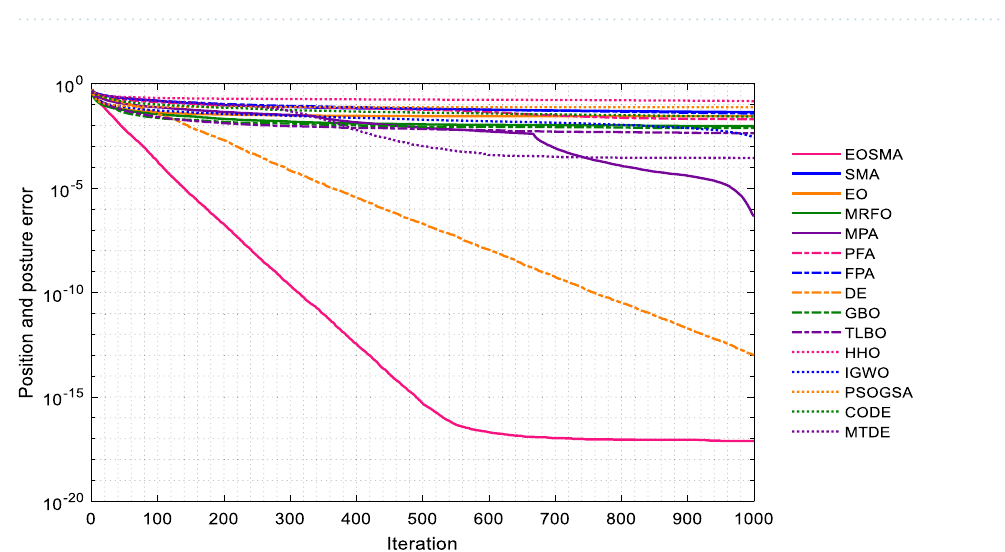
Figure 13. Average convergence curve of randomly generated pose